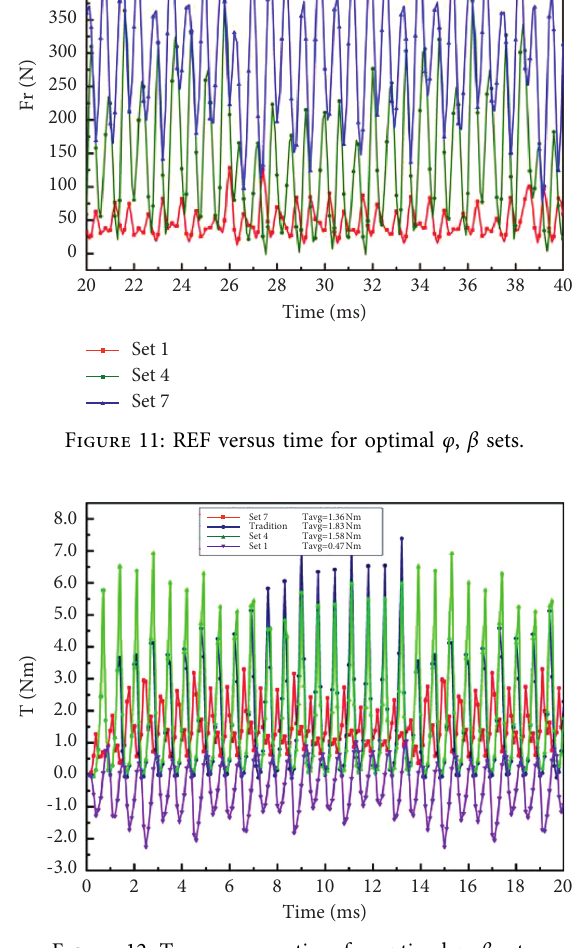
Figure 12: Torque versus time for optimal φ , β sets.